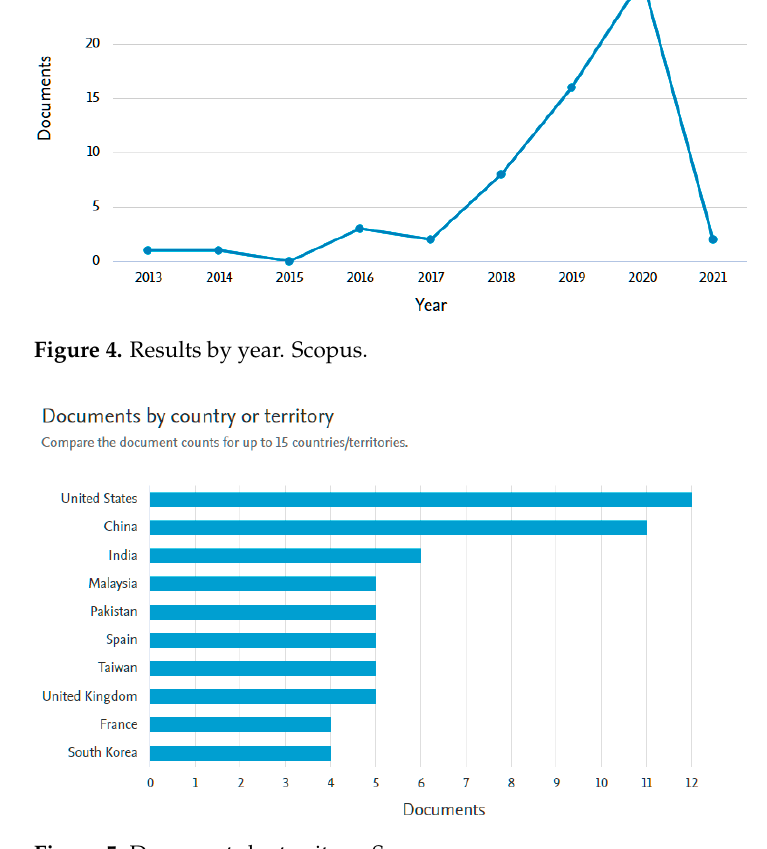
Figure 5. Documents by territory. Scopus.